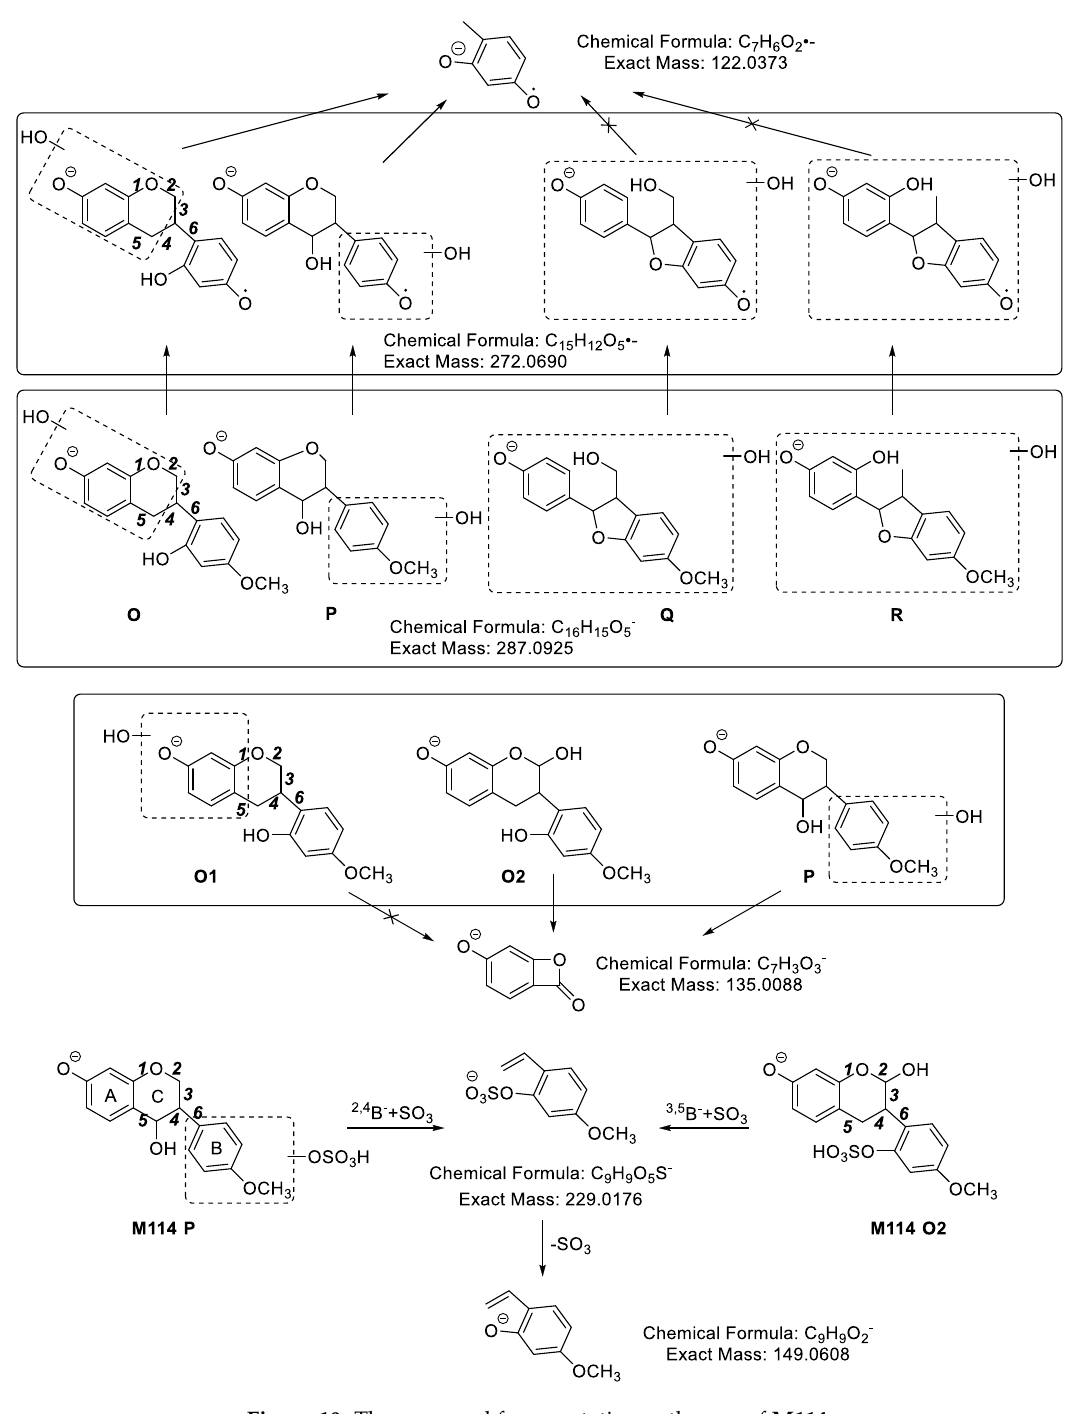
Figure 10. The proposed fragmentation pathways of M114 .